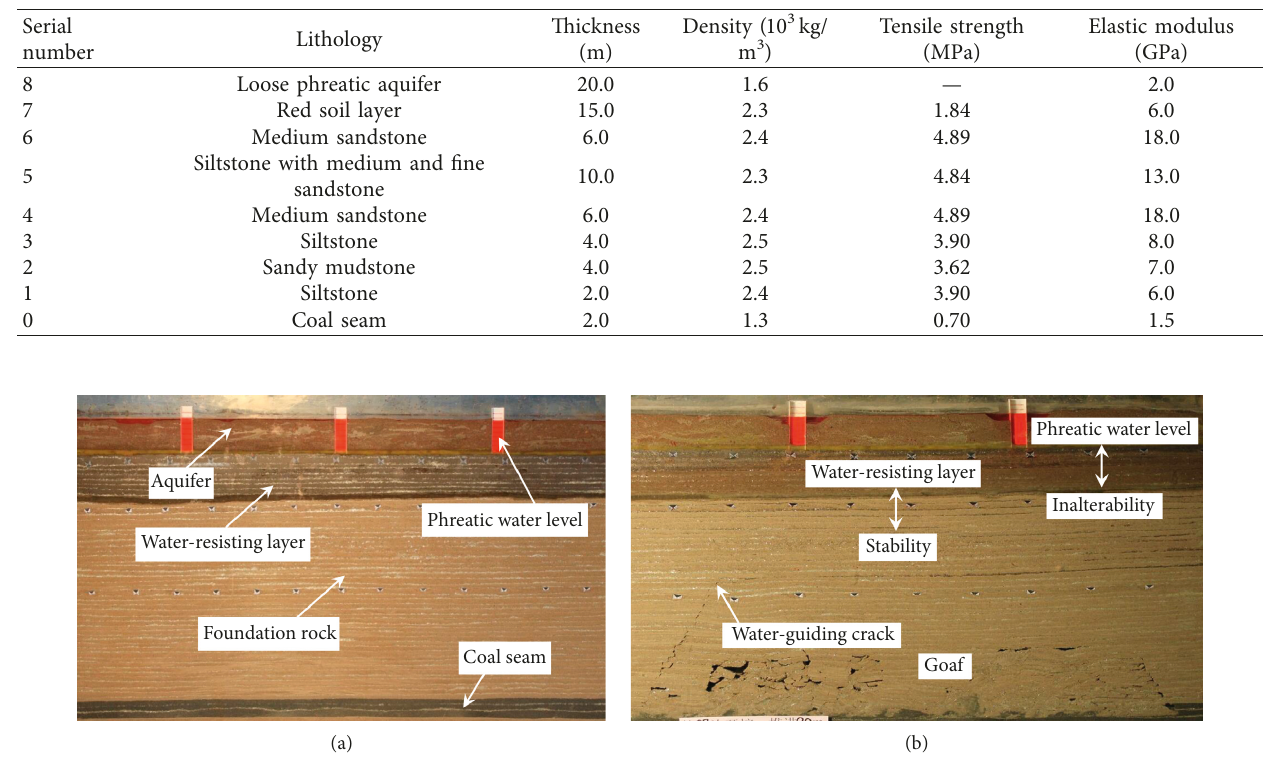
Table 4: Mechanical parameters of overlying strata above working face.